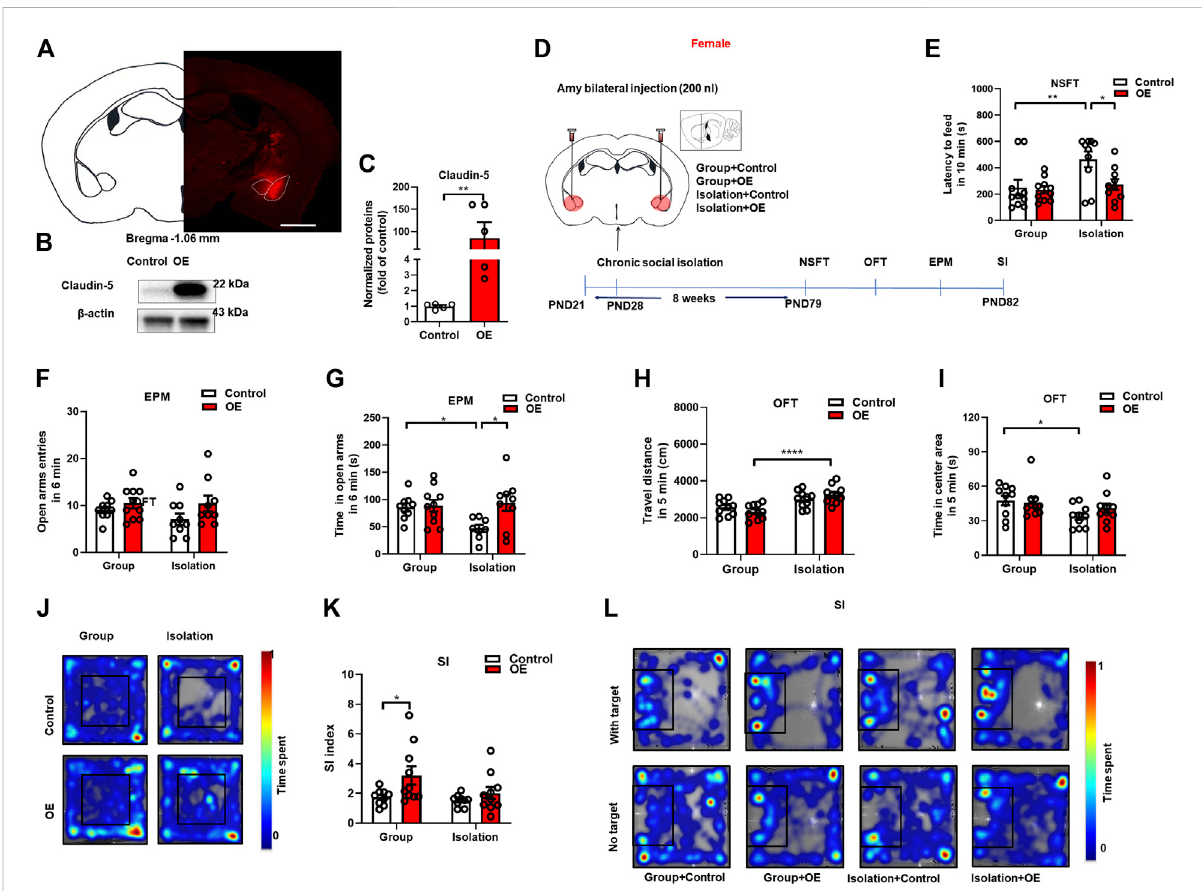
FIGURE 6 Overexpression of Claudin-5 in the amygdala prevented anxiety-like behavior induced by social isolation in female mice. (A) Representative images of AAV-infected cells in the amygdala of female mouse brain coronal sections ( − 1.06 mm relative to bregma). Scale bar = 1 mm. (B) Immunoblot analyses of AAV9-CAG-mCherry (Control) or AAV9-CAG- Cldn5 -mCherry (OE) expression in the amygdala. (C) Quantitative assay of Claudin-5 ( n = 5). (D) Experimental procedure. (E) The novelty suppressed feeding test. (F,G) The time and entries in open arms in the elevated plusmazetest. (H) Thelocomotoractivityintheopen fi led test. (I,J) Thetime inthecenterarea andrepresentativeheat maps ofopen fi eldtest. (K,L) The social interaction test and representative heat maps. ( n = 8 – 10), Two-way ANOVA, Bonferroni ’ s test. Data were mean ± SEM, * p < 0.05, ** p < 0.01, **** p <